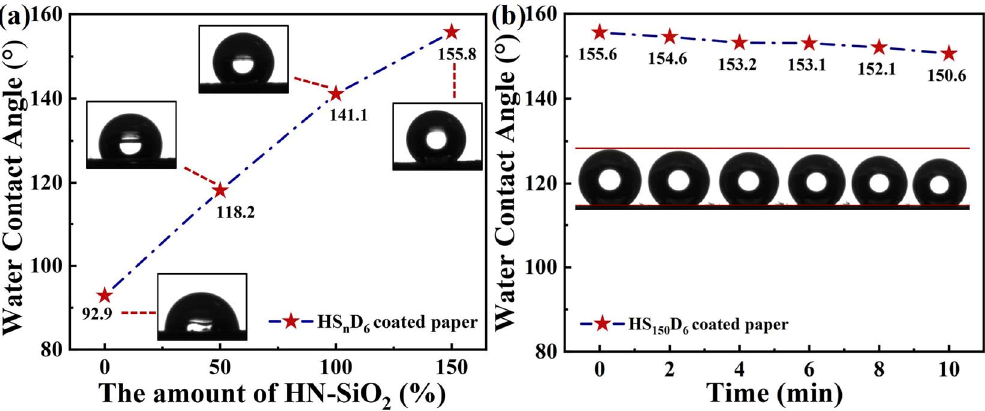
Figure 7. ( a ) Water contact angle of HS n D 6 coated paper. ( b ) Change of WCA of HS 150 D 6 coated paper.